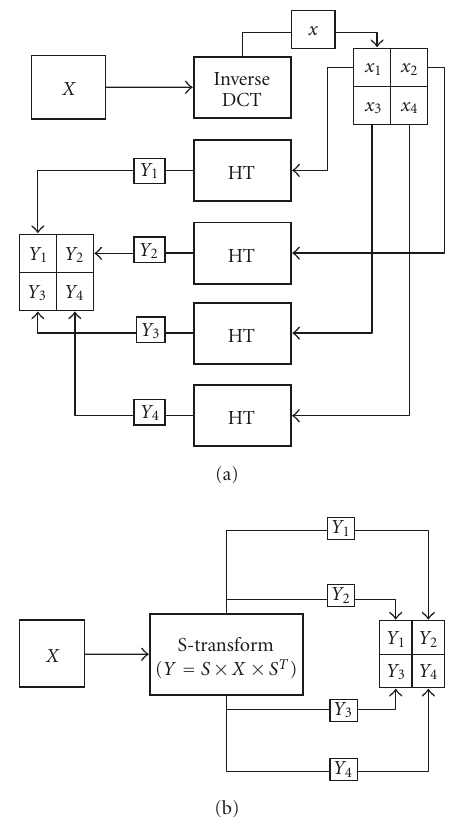
Figure 3: Comparison between two DCT-to-HT conversion schemes: (a) pixel domain, (b) transform domain.